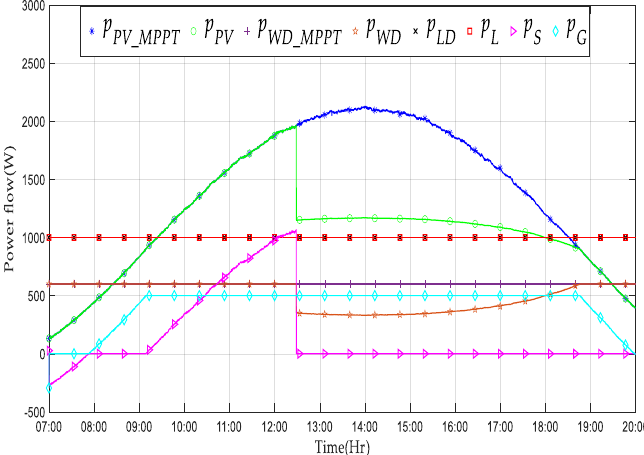
k , k , and soc with optimization by applying the coefficient. D _ D real